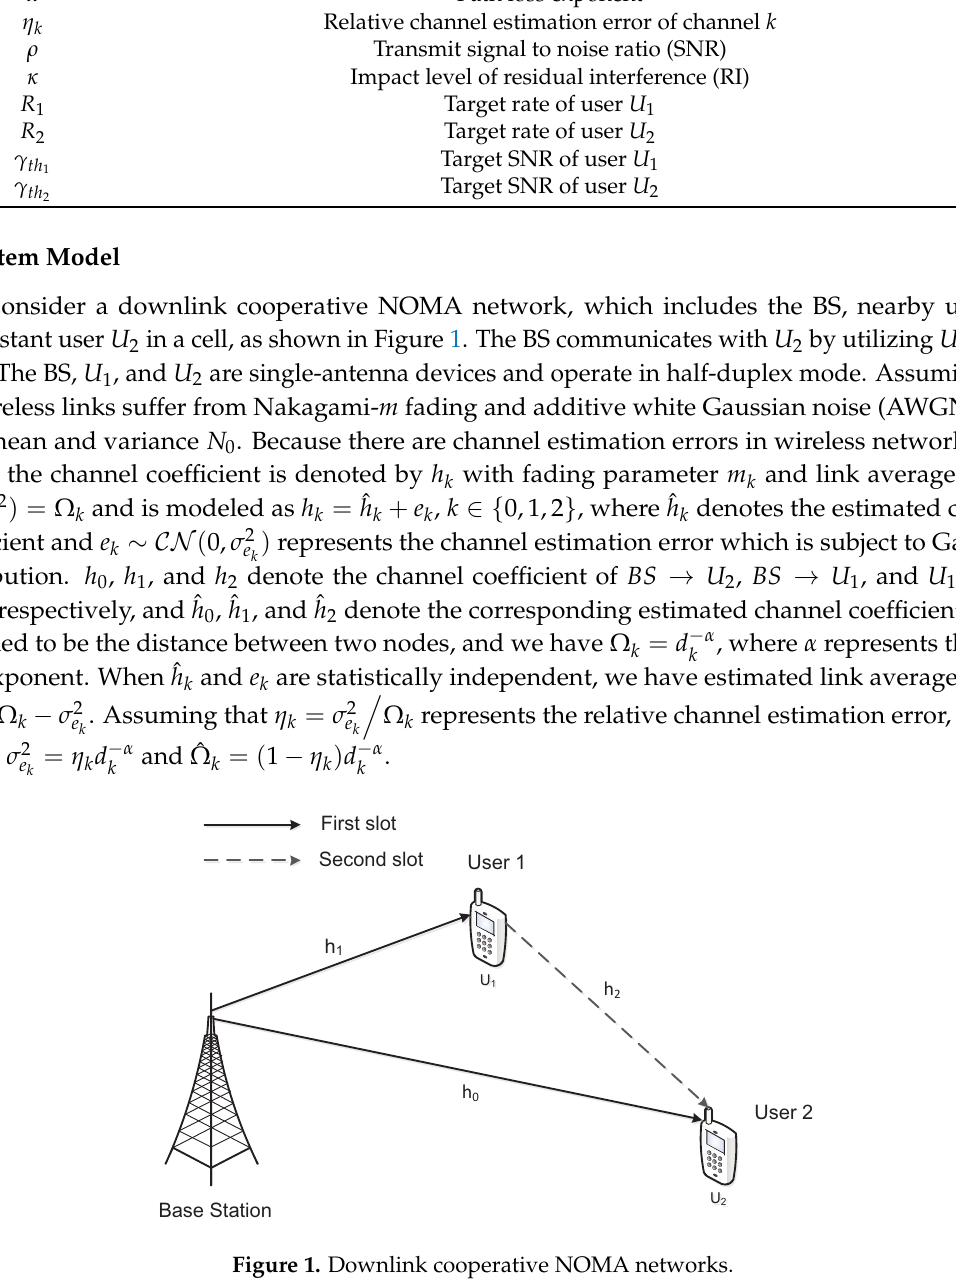
Figure 1. Downlink cooperative NOMA